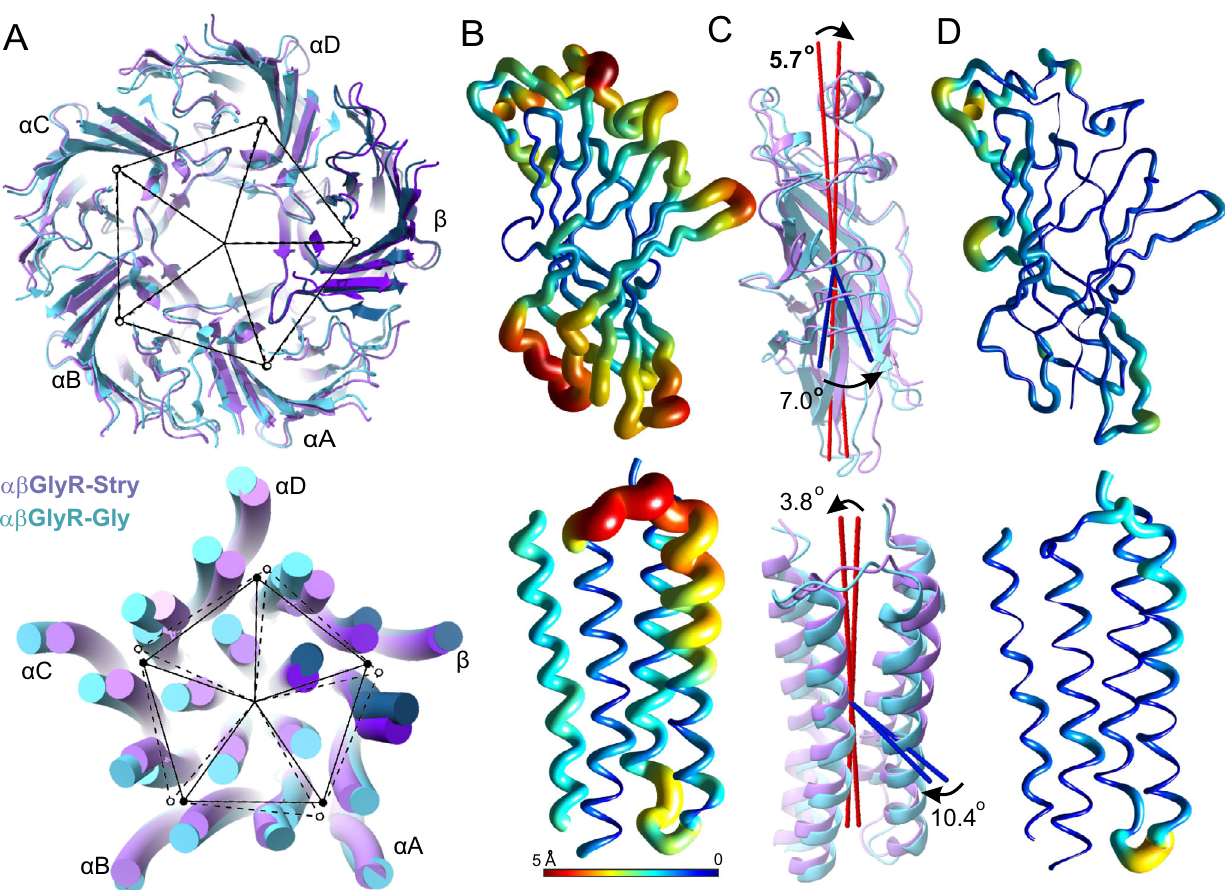
Fig. 4 | Global conformational differences between αβ GlyR-Stry and αβ GlyR- Gly. The ECD and TMD were analyzed separately, with respective results shown in the top and bottom rows. A Image overlay showing subunit displacement.